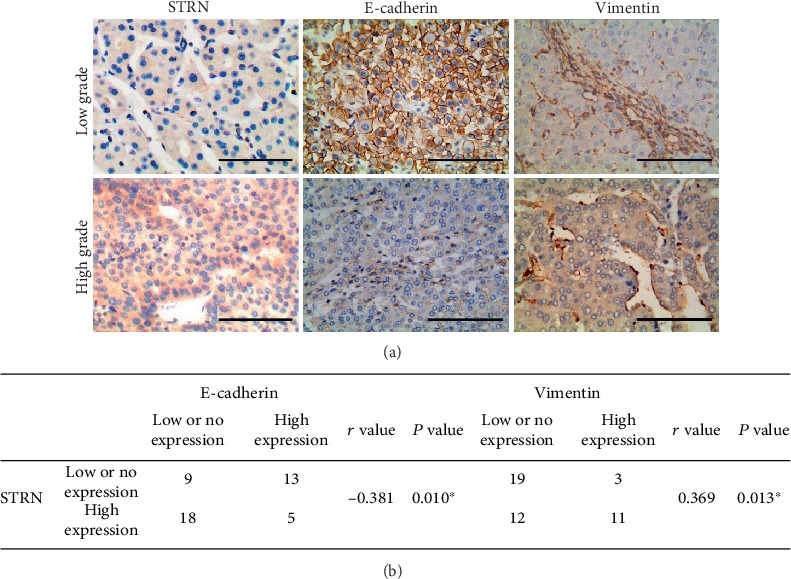
Correlation of STRN expression with E-cadherin and Vimentin expression in human HCC tissues. (a) Representative staining of STRN, E-cadherin, and Vimentin in HCC tissues by immunohistochemical analysis. Images from a low-grade HCC, which exhibits low STRN expression, positive E-cadherin membranous staining, and negative Vimentin expression, and images from a high-grade HCC, which exhibits high STRN expression, reduced E-cadherin membranous staining, and positive Vimentin expression, are shown. Scale bars, 100 μm. (b) STRN expression was negatively correlated with E-cadherin expression but positively correlated with Vimentin expression in HCC tissues, as analysed by Spearman correlation.∗P < 0.05.